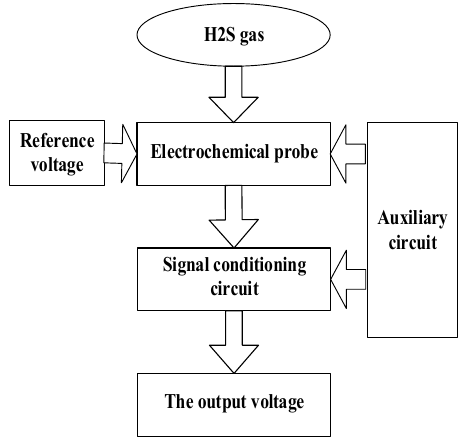
Figure 1. Measurement Circuit Design Diagram of the Sensor.